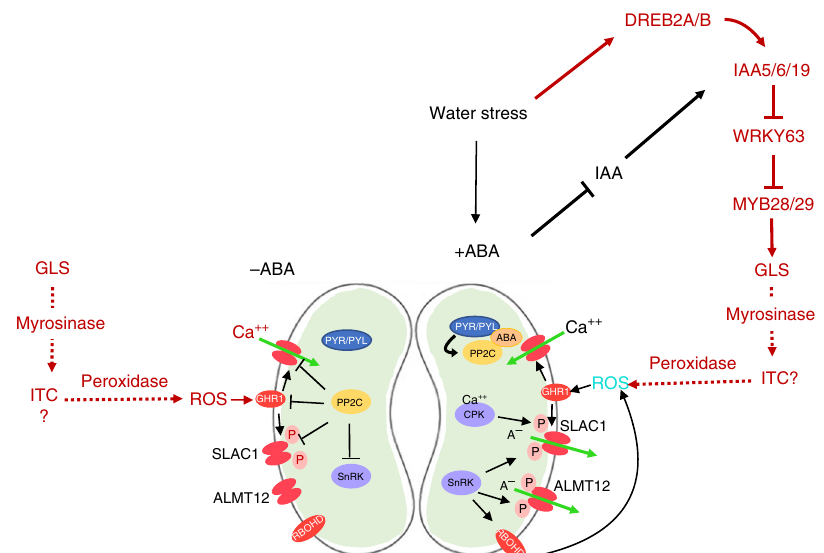
Fig. 5 A proposed model for GLS action during stomatal regulation. Adapted from 26 . GLS regulation diagramed in red. Water de fi cit induces DREB2A/B expression which promotes expression of IAA5/6/19 and maintenance of GLS levels. Myrosinase acts on GLS to produce degradation products, including isothiocyanates (ITC), that promote ROS production via a peroxidase 22 . An increase in ABA levels also results in decreased IAA levels in guard cells 27 which acts to stabilize IAA5/6/19. In the absence of water stress, GLS acts to promote stomatal closure via ROS